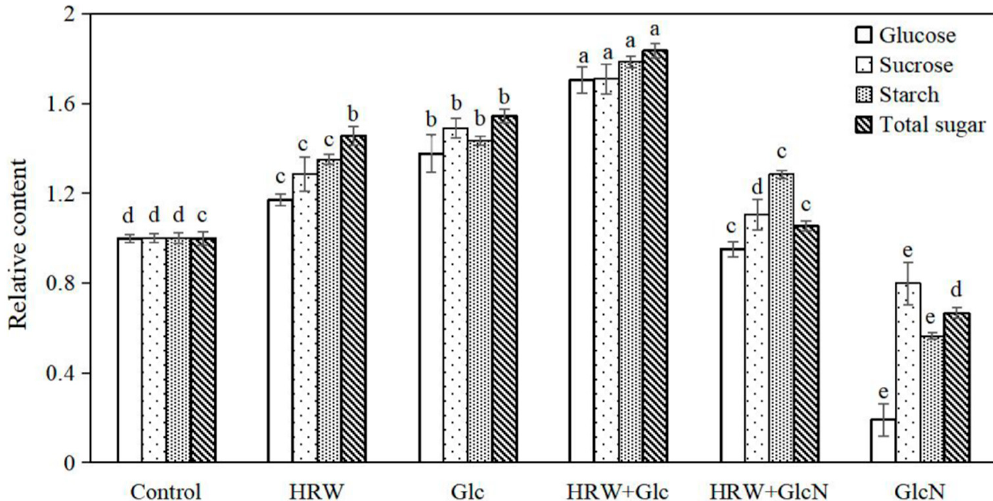
Figure 2. Effects of HRW, Glc and GlcN on glucose, sucrose, starch, and total sugar contents during adventitious rooting. n = 30 explants per replicate. Bars with different lower case letters were significantly different ( p < 0.5). HRW: hydrogen rich water; Glc: glucose; GlcN glucosamine. The relative content (compared to the control) is displayed in the figure.